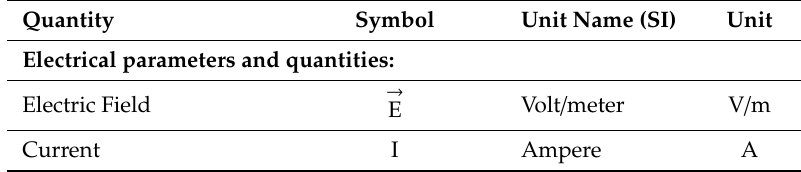
Table A1. Summary table of the electrical, magnetic, and dimensional parameters and units. Quantity Symbol Unit Name (SI) Unit Electrical parameters and